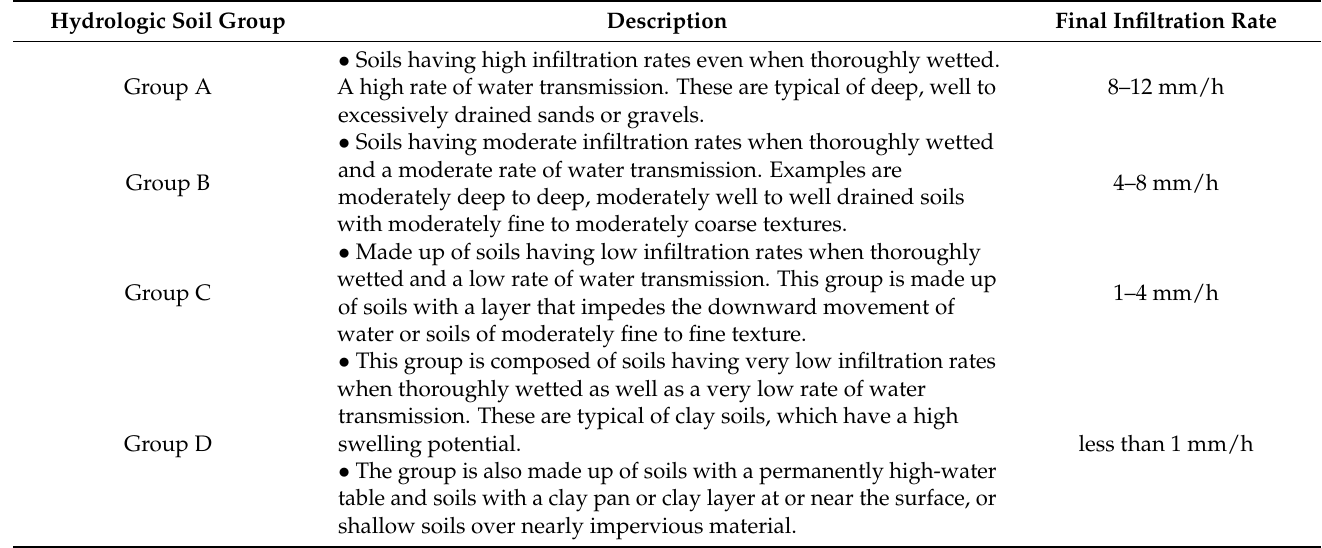
Table 1. Characterization of Hydrological Soil Groups.